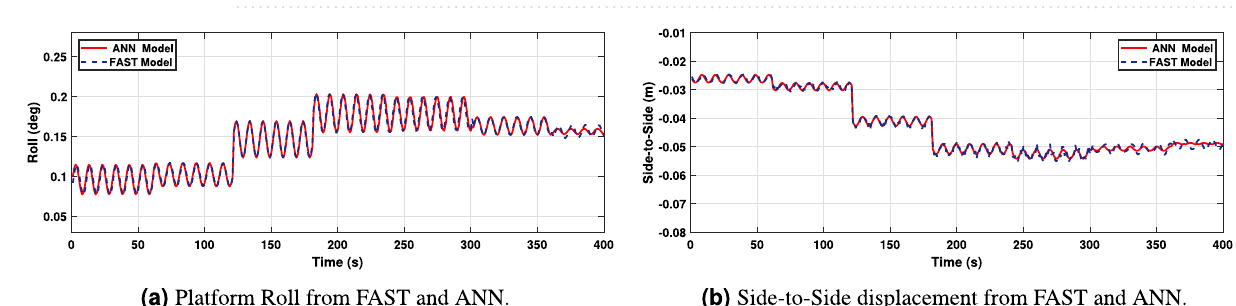
Figure 14. Platform‘ Pitch angle and top-tower displacement.